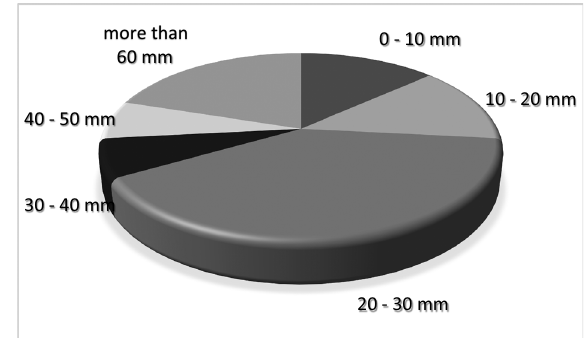
Figure 2: Research number percentage regarding the length of the steel fi